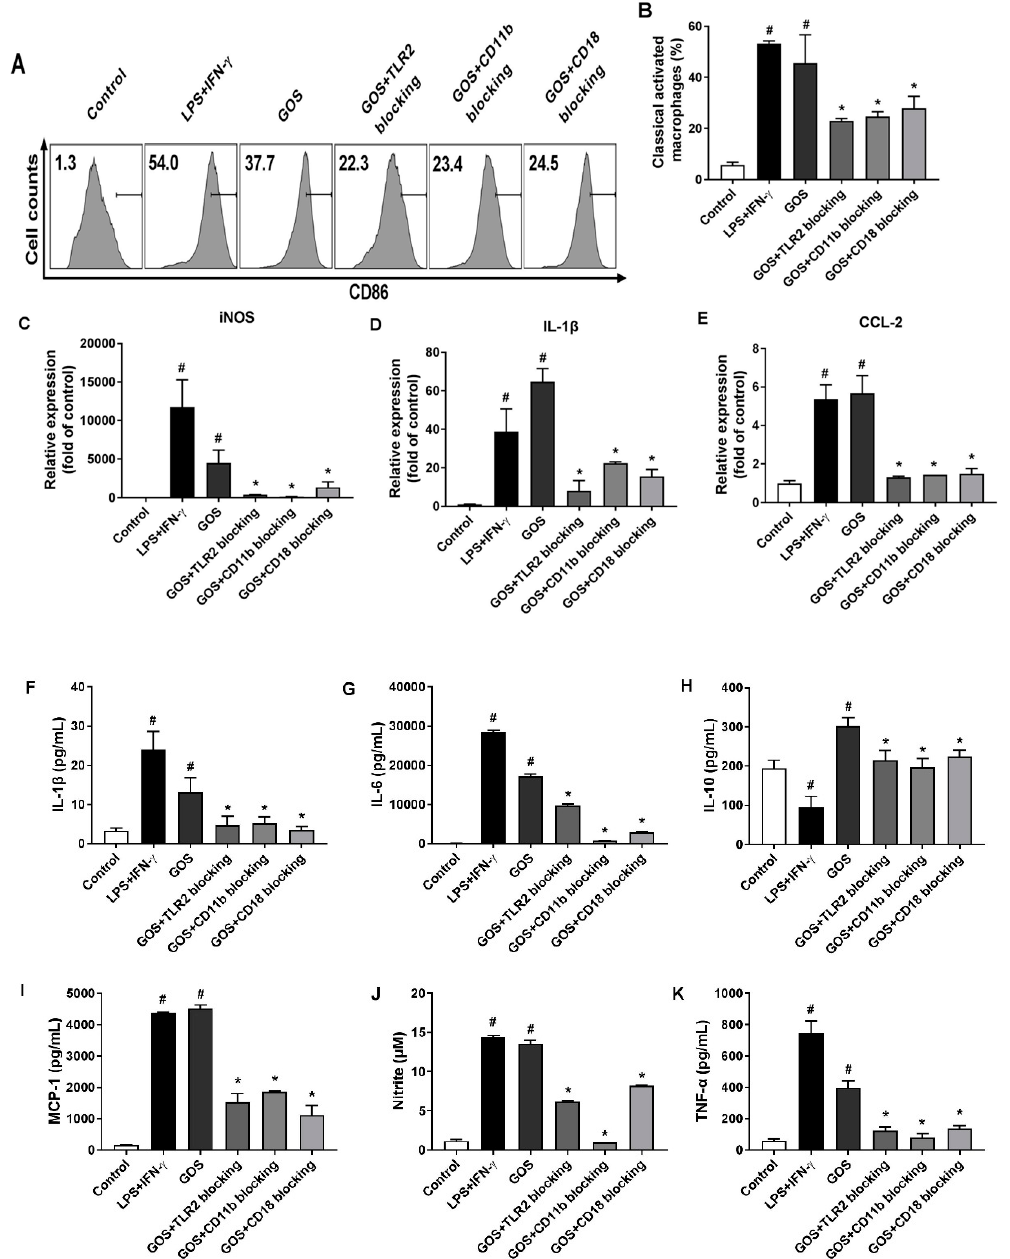
Figure 6. Effects of receptor blocking of TLR2 and CR3 (CD11b/CD18) on GOS-induced M1 marker expression, cytokines production, and nitrite release in BMDMs. Expression of CD86 on BMDMs cell surface ( A ) and accordingly the percentage of M1 phenotype macrophages ( B ) after receptor blocking and GOS (100 µg/mL) treatment were analyzed by flow cytometry. M1 marker gene expression of iNOS ( C ), IL-1 β ( D ), and CCL-2 ( E ) were quantified by RT-qPCR. Production of cytokines of IL-1 β ( F ), IL-6 ( G ), IL-10 (H), MCP-1 ( I ), and TNF- α ( J ), as well as the release of NO ( K ) in BMDMs were measured by ELISA kits. # —Indicated significant difference versus the control group at p < 0.05. * — Indicated significant difference versus the GOS group at p < 0.05.